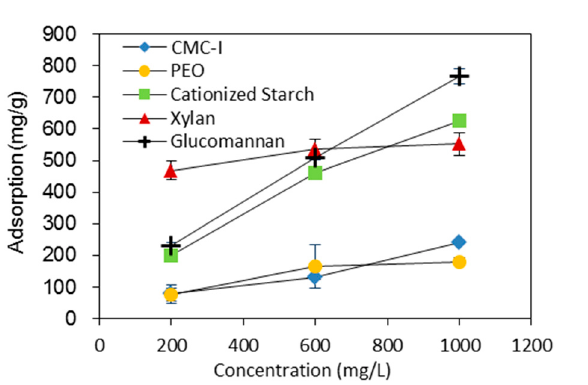
Figure 4. SEM images of recycled fiber paper reinforced by ( a ) undispersed BC and ( b ) glucomannan dispersed BC. 3.3. BC Fiber Dispersion by Surface Oxidation Electrostatic repulsion is another important mechanism to improve BC fiber dispersion. TEMPO-mediated oxidation method was used to oxidize the surface of BC fibers. The C6 on anhydroglucose unit is selectively oxidized into carboxylic acid [28] and the negative charges on BC fiber surfaces may repulse each other preventing the fiber from aggregation. The oxidation was controlled at a low level avoiding the excessive decrease of the hydrogen bonds between BC fibers and plant fibers, as well as preventing the degradation of BC. BC fiber samples with different oxidized levels were numbered as OBC-2, OBC-1, and OBC-0.5, and their carboxyl contents were measured as 1.78, 1.38, and 0.41 mmol/g, respectively. The suspensions (250 mL and 0.3 g/L) produced from all of the three oxidized BC samples did not aggregate within 50 min, indicating the TEMPO-mediated oxidation effectively improves the BC fiber dispersion or colloidal stability. The oxidized BC fibers were mixed with recycled fibers to produce reinforced paper. Figure 5a showed that the air permeability of the recycled fiber decreased by adding OBC, indicating OBC was well dispersed during paper forming [3]. At high oxidation level, the OBC reinforced paper had slightly increased air permeability may be due to the excessive degradation of BC. Figure 5b showed that adding TEMPO-mediated oxidized BC fiber does not help to improve the dry tensile index of paper. However, the wet tensile index improved greatly, especially for the BC fiber with the lowest oxidation level (OBC-0.5), i.e., from 0.89 N·m/g to 1.59 N·m/g, increased by 80% (Figure 5c). The increase in wet tensile strength indicated covalent bonds formed between fibers [32]. The explanation was that some hydroxyls were not oxidized into carboxyls, but into aldehydes [28,33], especially at low oxidation level. The aldehydes may form hemiacetals or acetals with fiber hydroxyls, leading to the improvement in paper wet strength [32].